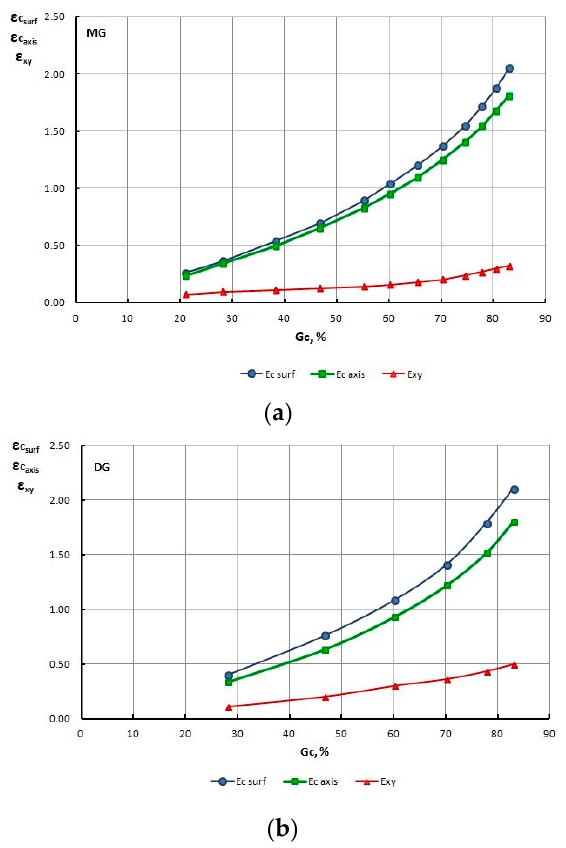
Figure 13. Change of strain level on the surface ε c surf , axis ε c axis and non-dilatational strain in wires drawn with low ( a ) and high ( b ) single section reductions, at a drawing speed of V c = 6.0 m/s, as a total drawing reduction function.